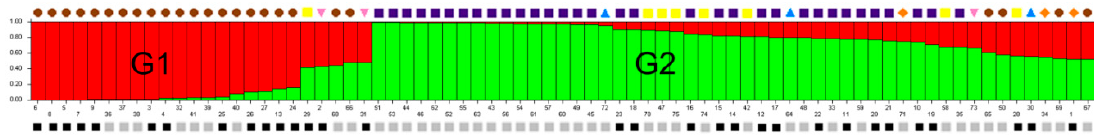
Figure 2. Four subgroups inferred from STRUCTURE analysis. The vertical coordinate of each subgroup means the membership coefficients for each accessions; the digits of the horizontal coordinate represent the accessions corresponding to Table S5; Red zone: G1, Green zone: G2, Blue zone: G3, and Yellow zone: G4; The colored samples upon the figure indicate the geographic distribution information of accessions. ◆ (orange) accessions from North America, ● (brown) accessions from Asia, ■ (purple) accessions from Europe, ■ (yellow) accessions from Africa, ▲ (blue) accessions from South America, and ▼ (pink) accessions from Oceania; The simples below the figure indicate the rust trait information of accessions. ■ (black) accessions with resistant (HR and R) traits, and ■ (grey) accessions with susceptible traits (HS and S).